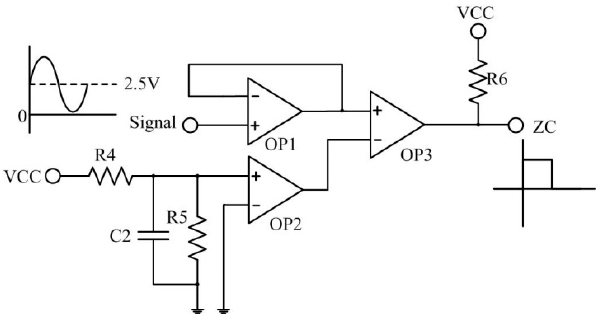
Figure 2. Voltage sampling circuit.